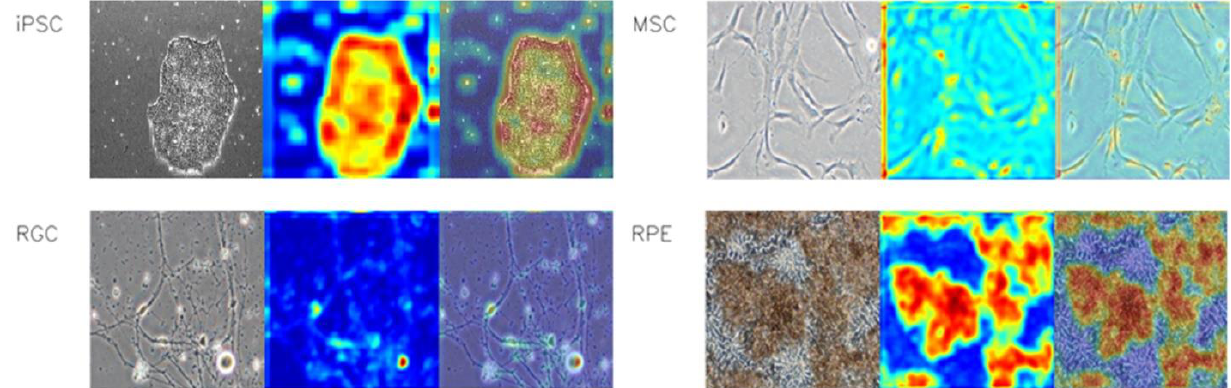
Figure 4. Comparison of four cell types with the heatmap imaging. For each indicated cell type, the left panel shows the representative phase-contrast microscopy image, the middle panel shows the heatmap calculated by the CNN model, and the right panel shows the overlay of the heatmap and the input.